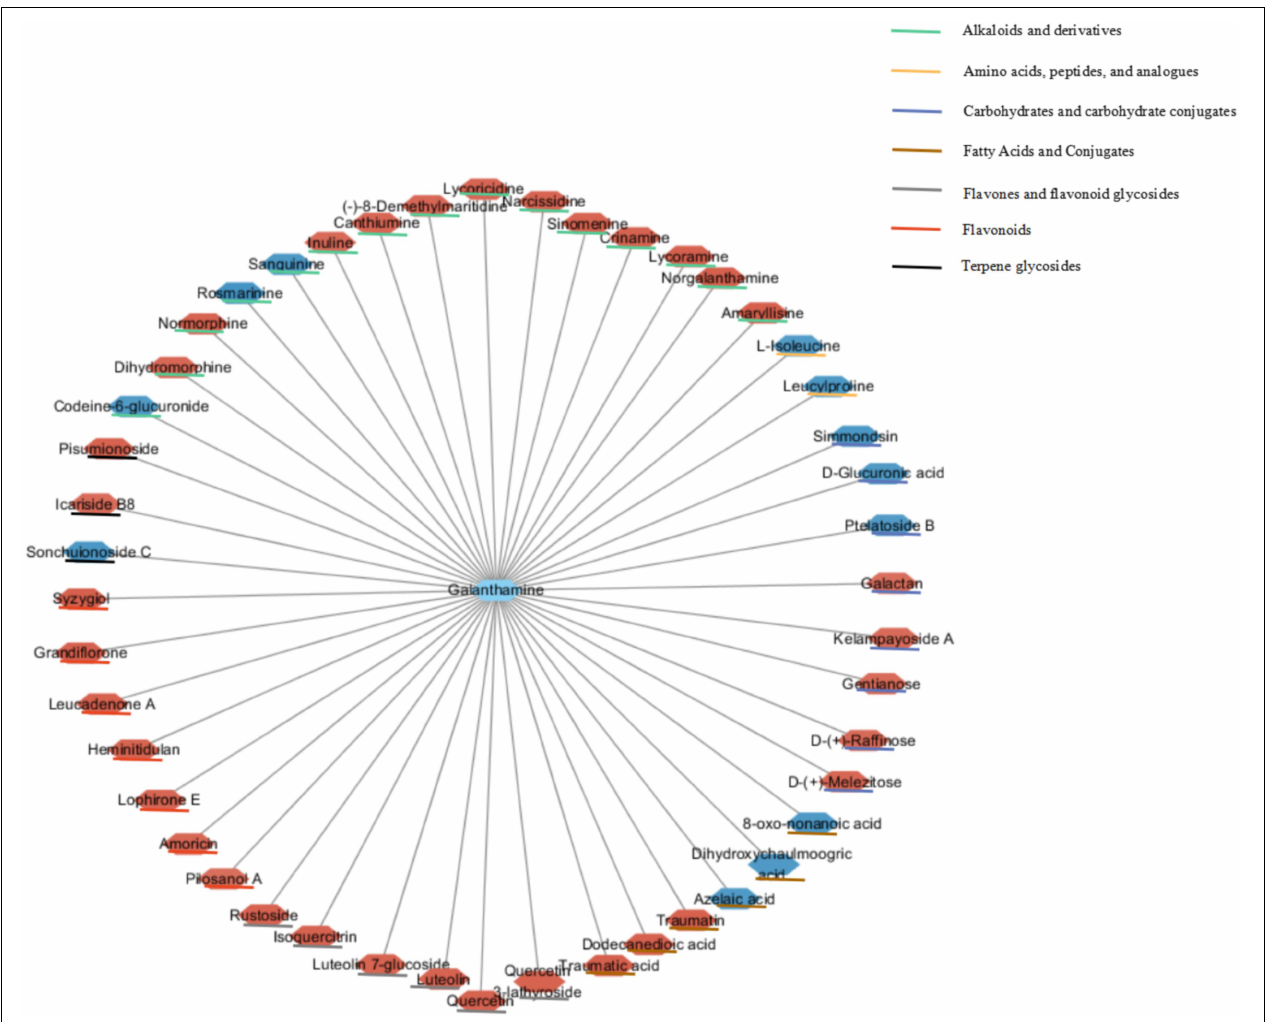
FIGURE 13 | Correlation network based on identified galanthamine and other metabolites with significant correlations. Node colors represent different types of metabolites. Edges between nodes represent correlation identified as significant at | r | > 0.9, p < 0.001, where red and blue nodes represent positive and negative correlations ( N =